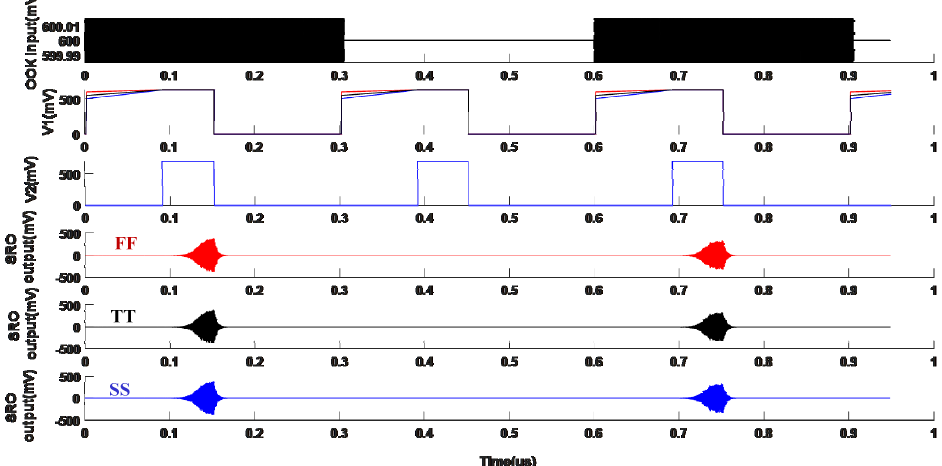
Figure 13. The simulation results illustrating the SRR’s immunity against process variations when the proposed quenching waveform is applied. From top to bottom: the input OOK signal, the proposed CQW voltage V 1 under process variations, the proposed CQW voltage V 2 , and the SRO output signals under process variations (the red line for the fastest-speed process corner (FF), the black is for the typical (TT), and the blue is for the slowest one (SS)).